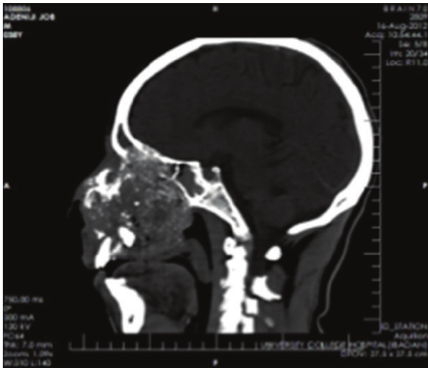
Figure 9: Photomicrograph of odontogenic keratocyst showing several daughter cysts. (A) Palisading of the basal cell layer. (B) Surface parakeratinisation. (C) Epithelial lining which is 6–8 cells thick ( ×